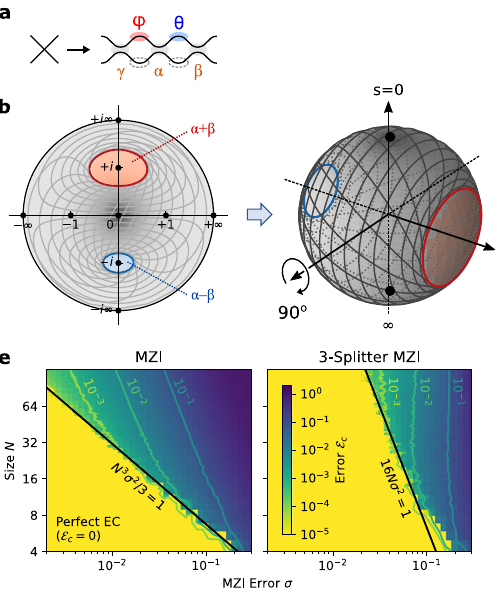
Fig. 3 | 3-splitter MZI design and simulated performance. a Schematic of 3-MZI. b Splitter Möbius transformation on s 2 C , which pushes the forbidden regions awayfrom s ={0, ∞ },correspondingtoaRiemannsphererotation. c Dependenceof matrixerror E 0 , E c onthesplittervariation σ ,contrastingthestandardand3-splitter MZIs ( fi xed mesh size N =256). d Scaling of corrected error E c with mesh size N ,